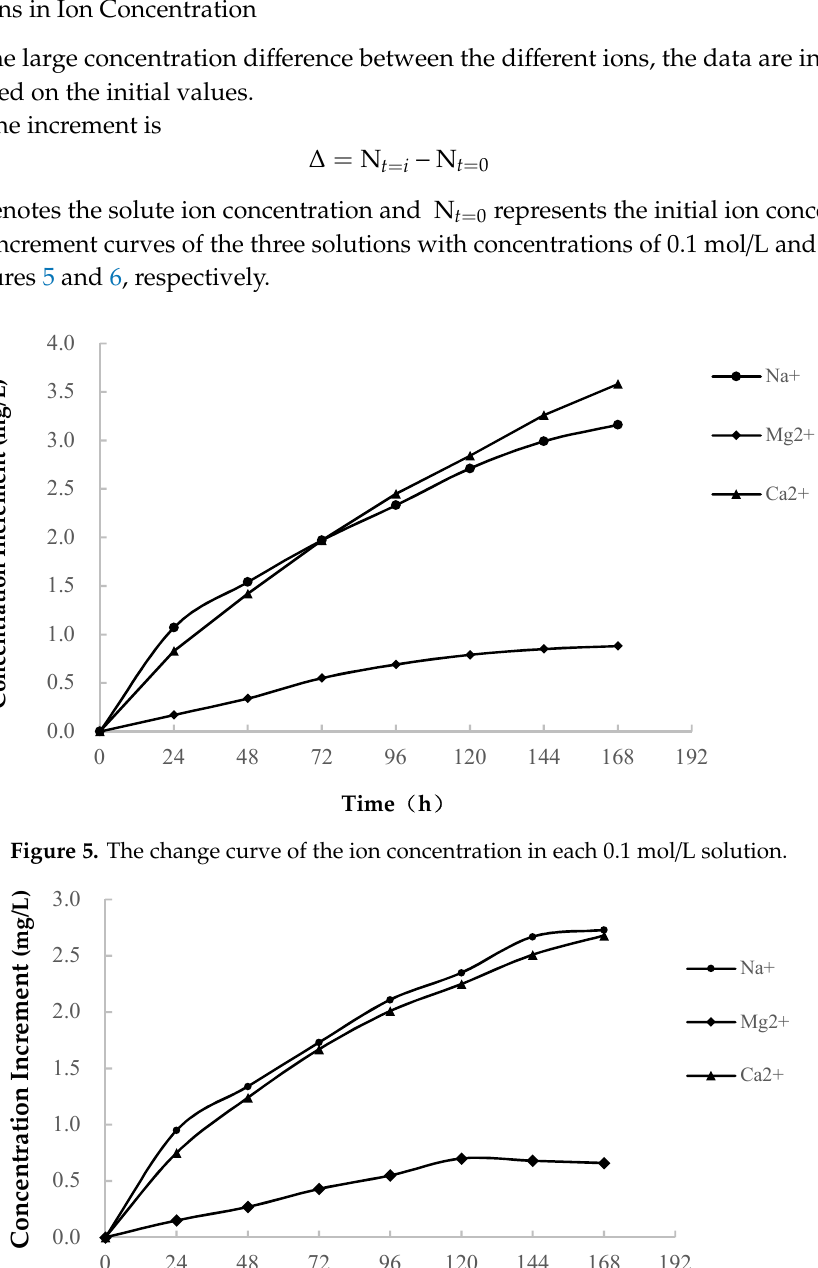
Figure 6. The change curve of the ion concentration in each 1 mol/L solution.